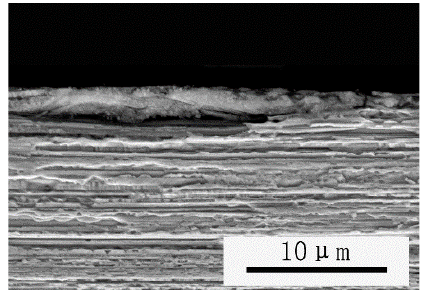
Figure 6. Edge section of wire material (typical